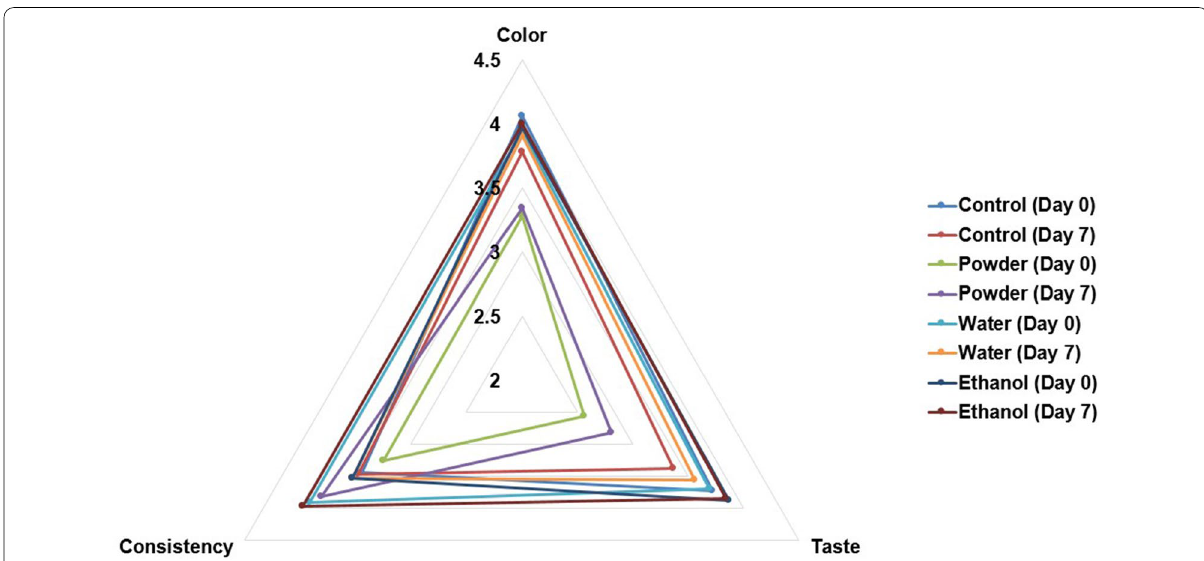
Fig. 4 Sensory evaluation data for color, taste, and consistency of yogurt samples during storage (4